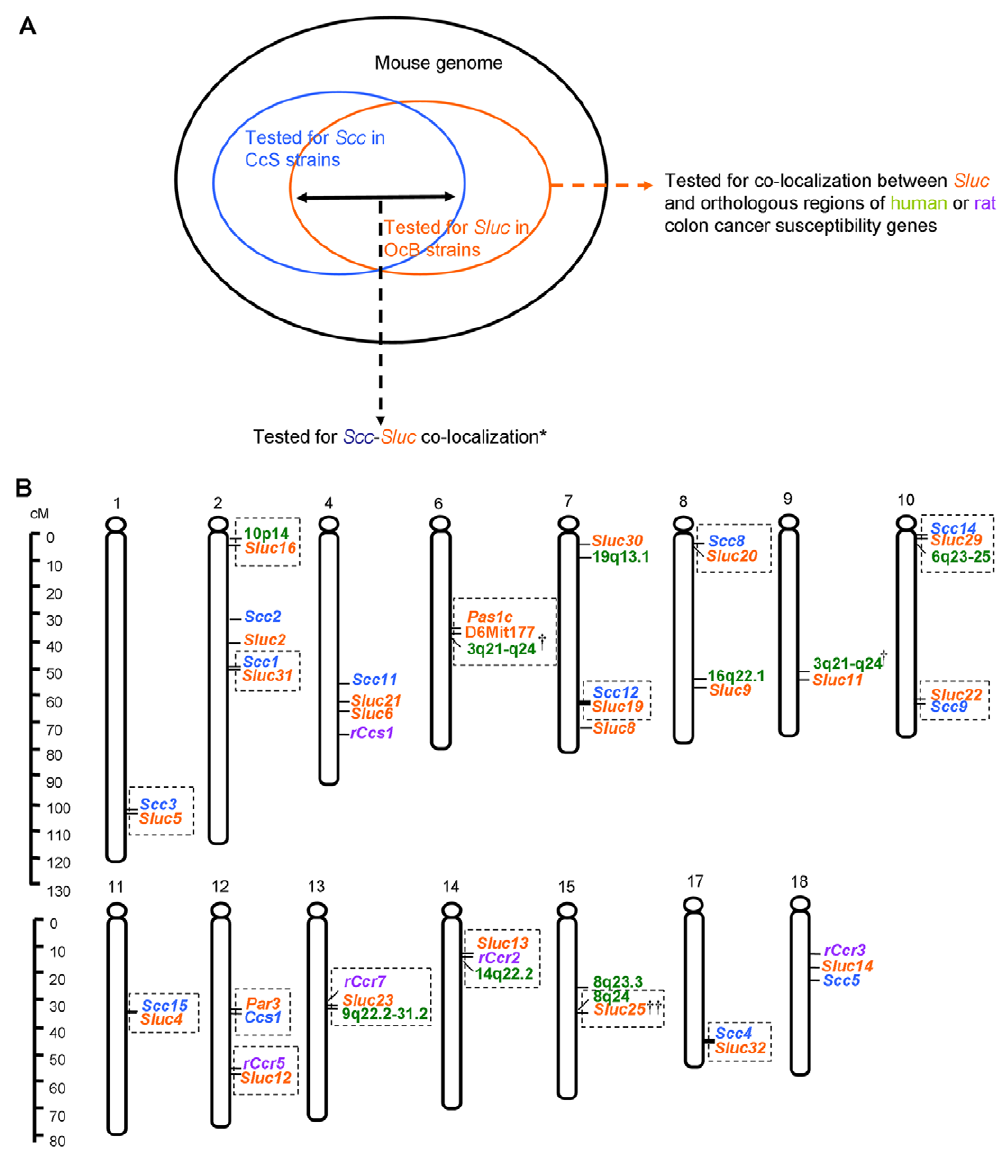
Figure 6. Interspecies correlation between colon and lung cancer susceptibility loci. A. Schematic representation of the part of genome used for the co-localization analyses. The Sluc loci analyzed here included also 2 Sluc loci identified in (CcS10 XCcS19)F2 mice and 1 CcS locus [44] and 1 Par locus [50] identified by other group. B. Interspecies correlation between colon and lung cancer susceptibility loci. This figure summarizes all 21 clusters of colon and lung cancer susceptibility loci mapped in mouse RC strains (orange for lung, blue for colon), human colon (green) and rat colon (purple). Clusters in which the lung and colon cancer loci mapped within 2.5cM of each other are highlighted in squares. Most colon and lung cancer susceptibility loci co-localize, with the exception of human 15q13 and 20p12.3 (colon), and rat rCcr6 and rCcr8 (colon). Orthologous regions of human 18q21, 11q23 (colon) and 5p15, 6p21 and 15q25 (lung), and rat rCcr1 , rCcr4 and rCcr9 (colon) are not informative since they were not tested for lung or colon cancer susceptibility in mouse RC strains. { Pas1c has also been detected in our (CcS-10 6 CcS-19)F2 cross at D6Mit177. Human colon cancer locus 3q21-q24 is mapped to an 18Mb region and orthologous to two mouse chromosomal regions: Chr.6 ( Pas1c ) and Chr.9 ( Sluc11 ), respectively. {{ Two human colon cancer susceptibility loci co-localize with a Sluc locus.